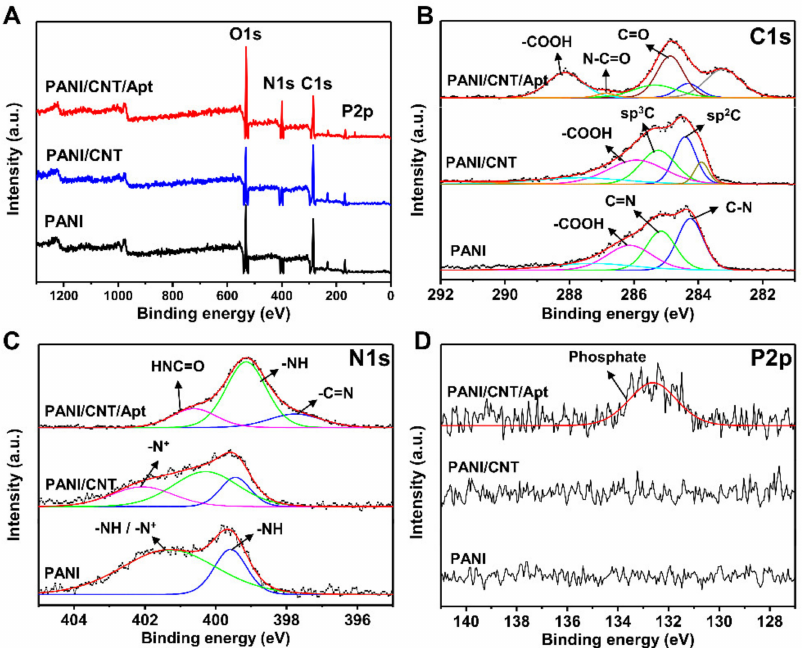
Figure 4. X-ray photoelectron spectroscopy (XPS) spectra of the modified electrode surfaces with PANI, PANI/CNT and PANI/CNT/Apt. ( A ) XPS wide spectra of the modified surfaces. ( B ) High- resolution XPS spectra of C1s, ( C ) N1s, and ( D ) P2p.